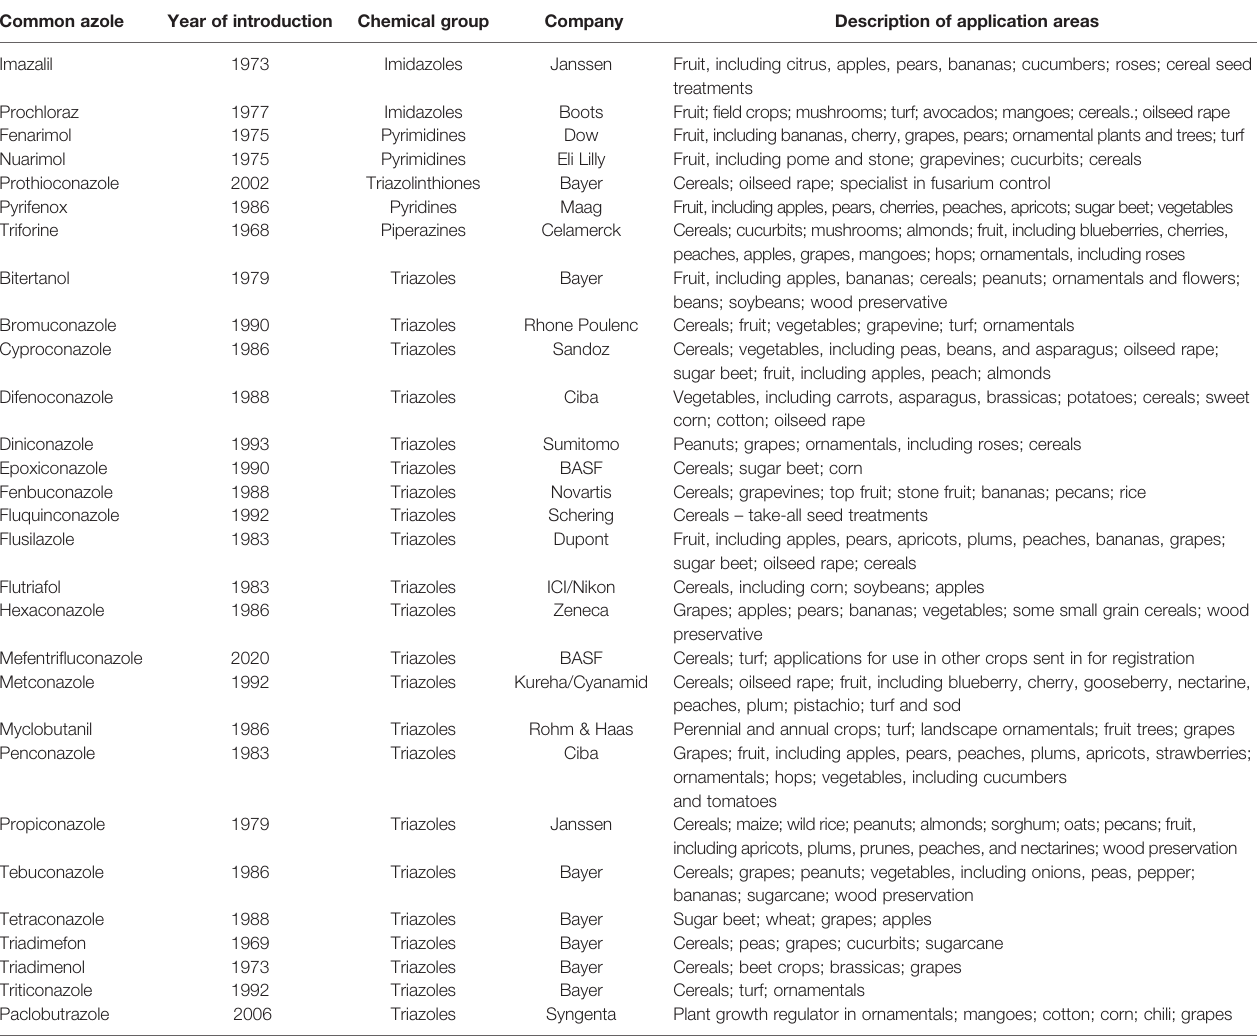
TABLE 1 | List of azoles development and timeline and main uses (modi fi ed from Russel, 2005). Common